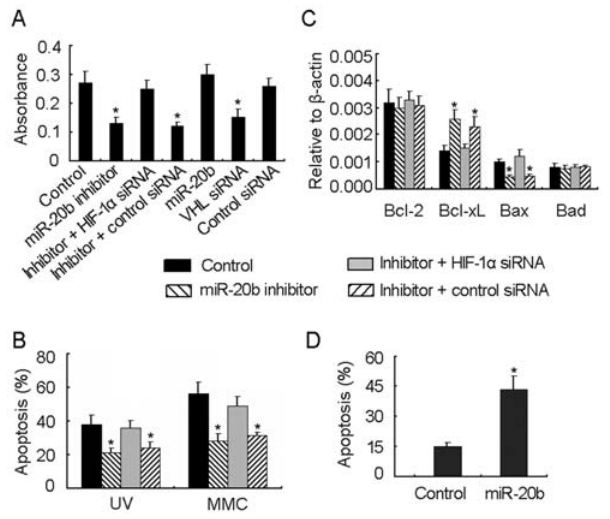
Figure 5. Differential expression of miR-20b affects different aspects of tumor cells. (A) miR-20b was required for H22 cell growth. H22 cells were transfected with miR-20b inhibitor or miR-20b inhibitor + HIF-1 a siRNA or miR-20b or VHL siRNA or control oligonucleotide for 24 hr. Then the cells were seeded in 96-well plate (5 6 10 3 per well) for 48 h in normoxia. The proliferation assay was performed with MTT Cell Proliferation Kit (Roche Diagnostics, IN) according to the manufacturer’s instructions. *, P , 0.05, compared with control. (B) Downregulation of miR-20b enhanced the resistance to apotosis. H22 cells were transfected with miR-20b inhibitor or miR-20b inhibitor + HIF-1 a siRNA for 24 hr. Then the cells (1 6 10 6 ) were irradiated by UVB (200 J/m 2 ) or treated with mitomycin C (MMC, 10 m g/ml)for 12 h. The cells were stained with PE-Annexin V and 7-AAD for apoptotic analysis by flow cytometry. *, P , 0.05, compared with control. (C) Analysis of the mRNA expressions of Bcl-2, Bcl-xL, Bax and Bad genes. H22 cells were transfected with miR-20b inhibitor or miR-20b inhibitor + HIF-1 a siRNA for 72 hr. The cells were used for the analysis of gene expression by real time RT-PCR. *, P , 0.05, compared with control. (D) Normoxic H22 cells were transfected with miR-20b for 24 hr. Then the cells were cultured under hypoxic condition for 12 h, and stained with PE-Annexin V and 7- AAD for apoptotic analysis by flow cytometry. *, P , 0.05, compared with